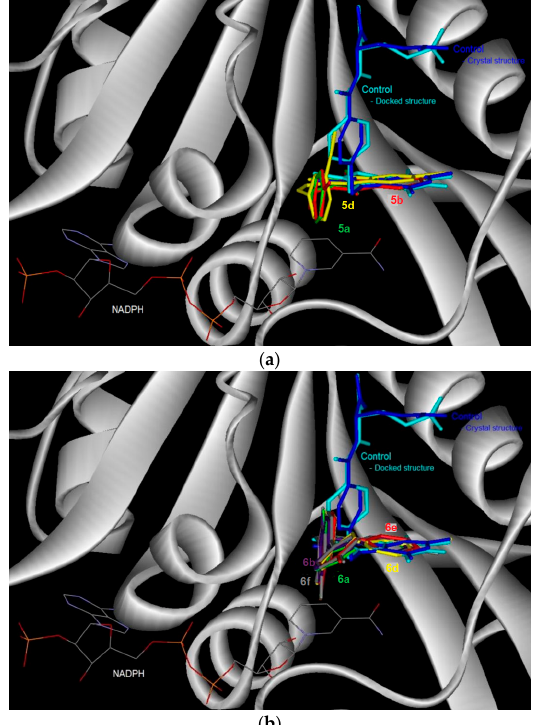
Figure 2. The binding conformation in human dihydrofolate reductase (DHFR) for the 6-bromoquinazolinones ( a ) and their 6-aryl–substituted derivatives ( b ).